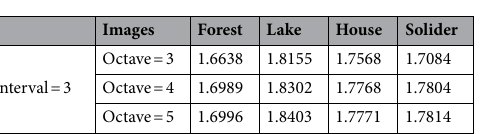
Table 1. Influence of octave on fusion.